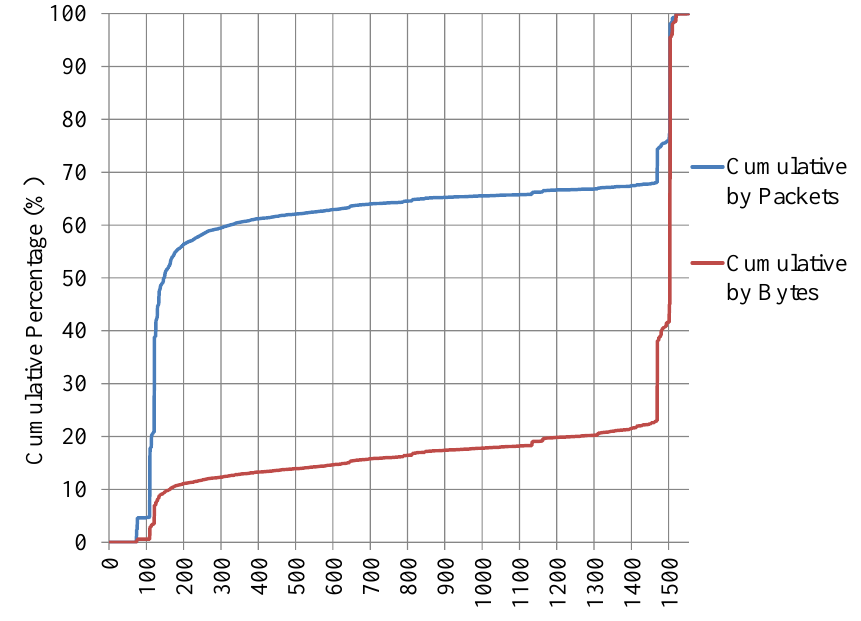
Figure 13. Tra ffi c analyses of Ethernet packets. Figure 13. Traffic analyses of Ethernet packets.